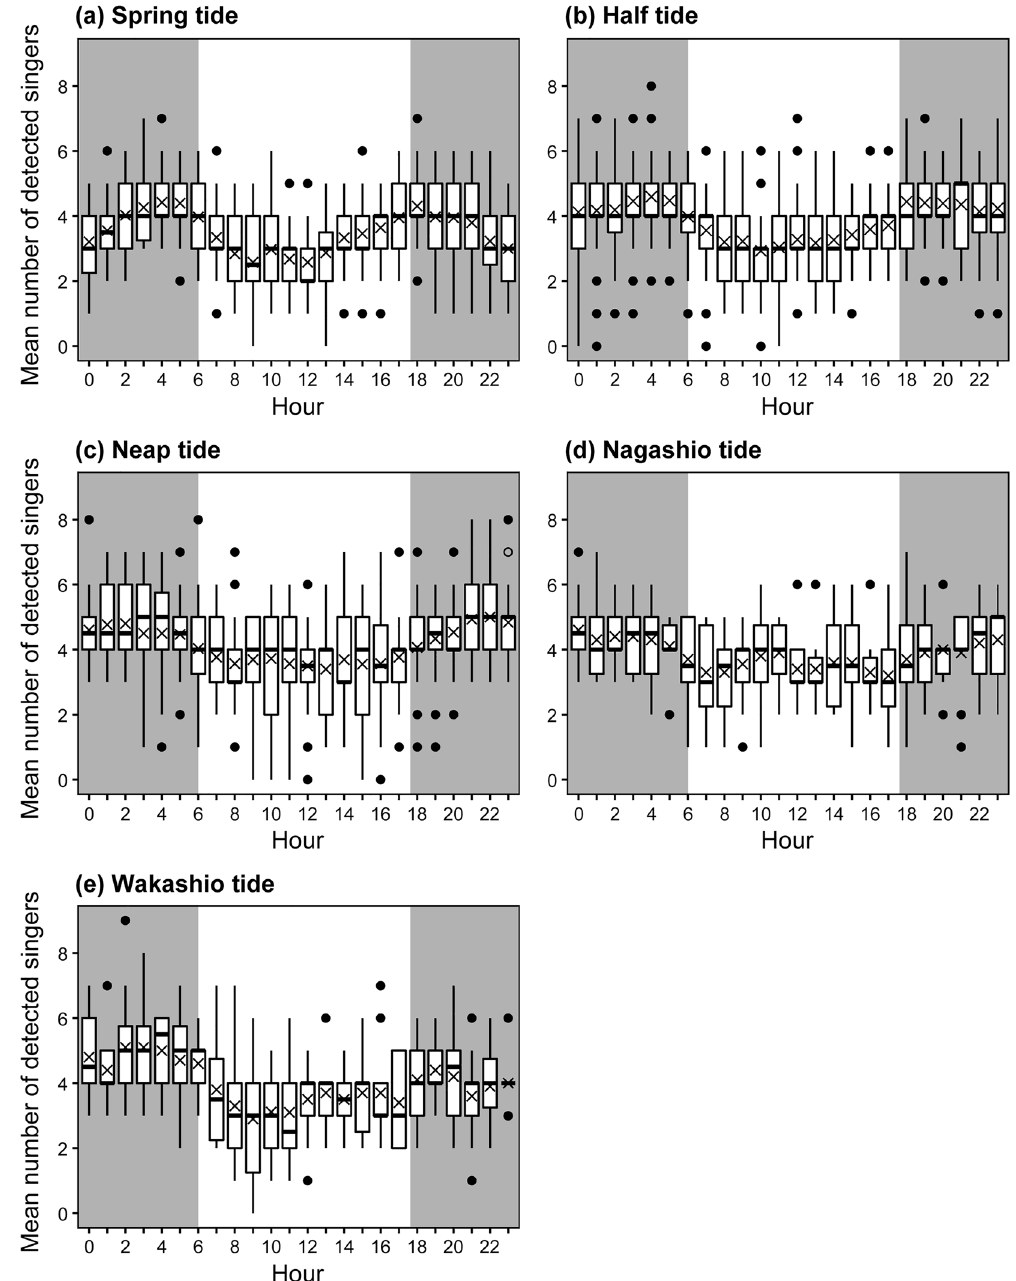
Figure 4. Diel variations in the mean number of detected singers for each tide type on the west side of Chichijima Island. The lines in the middle of boxes represent the median, and the cross marks show the mean. The bottom and top of the boxes indicate the 25th and 75th percentiles. Whiskers represent 1.5 times the interquartile range, and dots outside of the whiskers represent outliers. Grey and white areas indicate night and daytime,